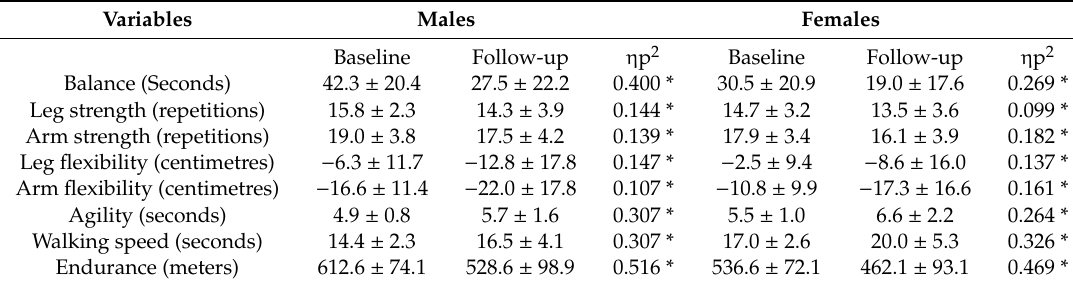
Table 2. Evolution of the physical fitness